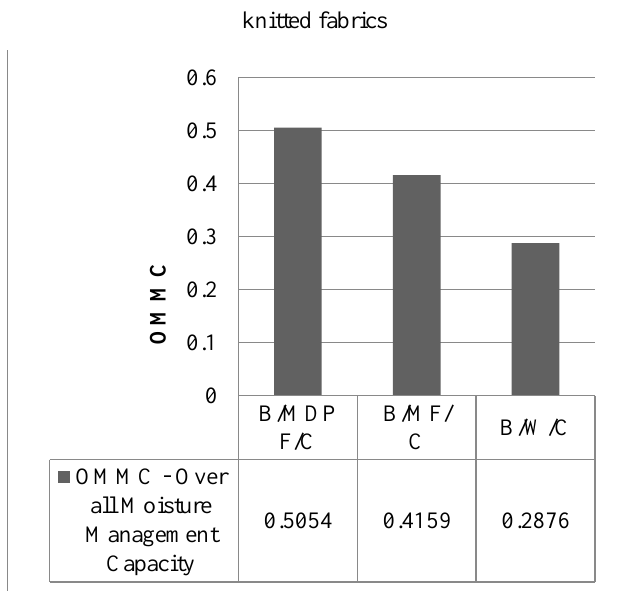
Fig. 6. Overall moisture management capacity of trilayer knitted